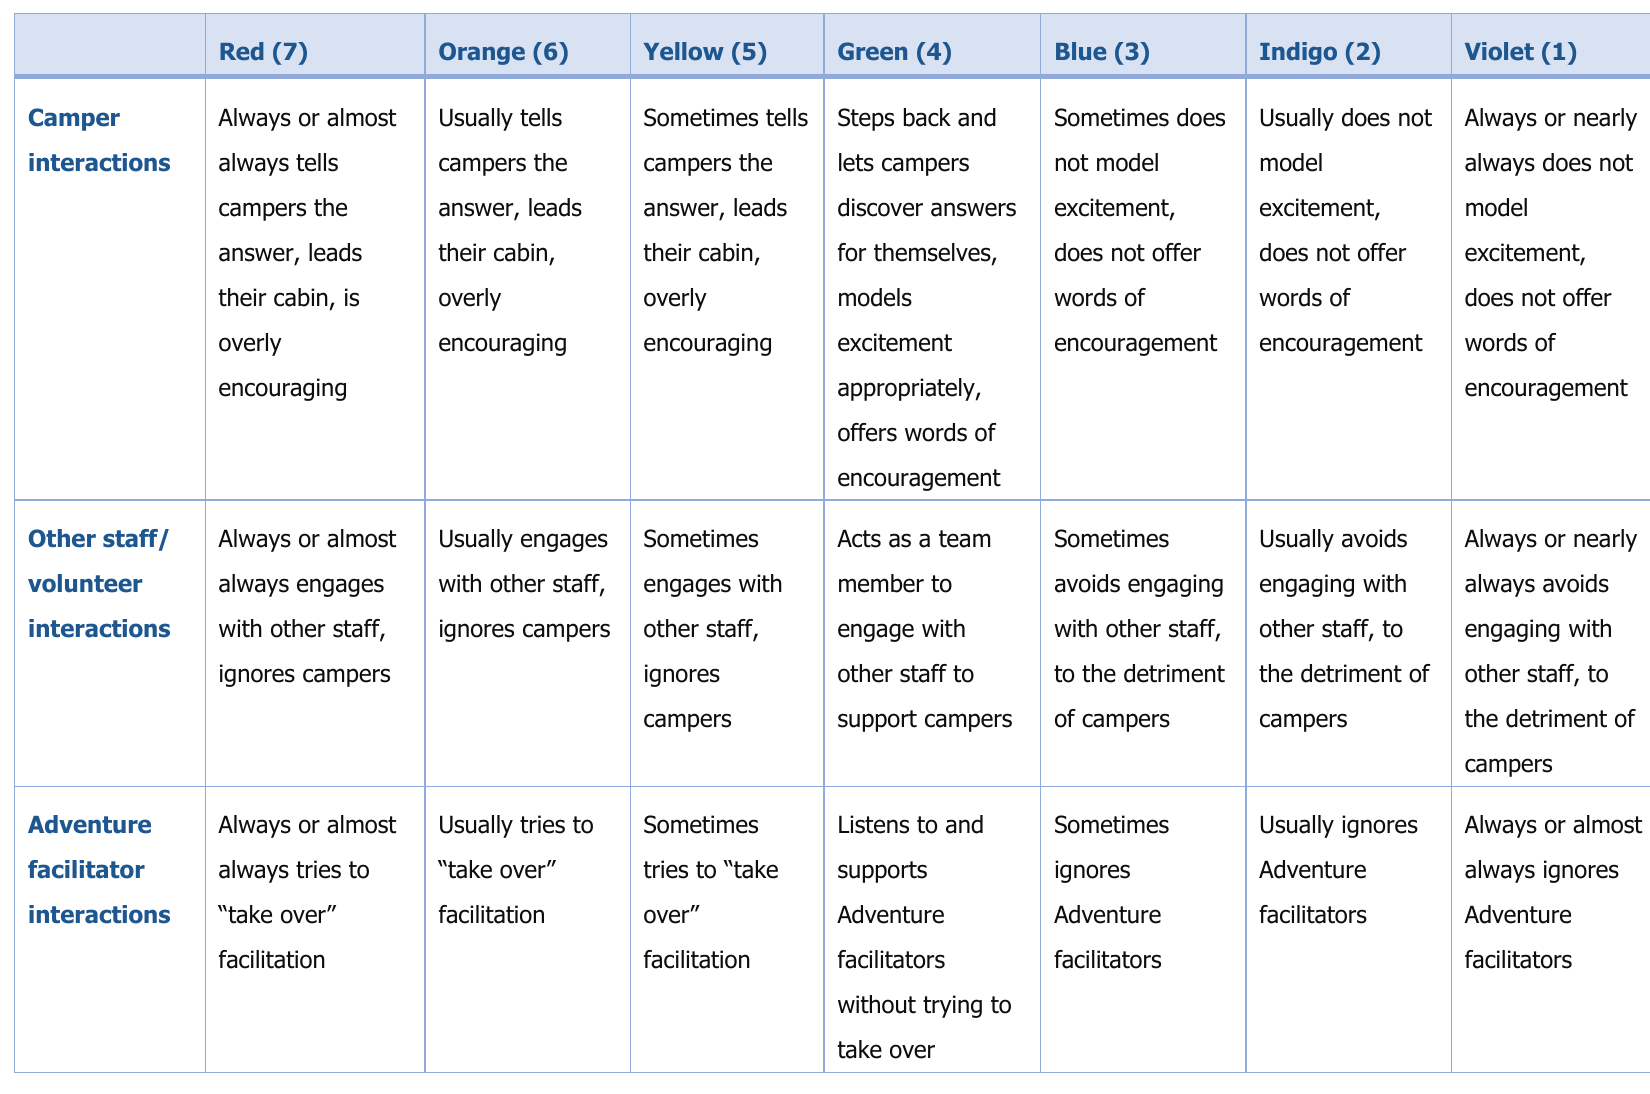
Table 1. Auxiliary Staff Engagement Observation